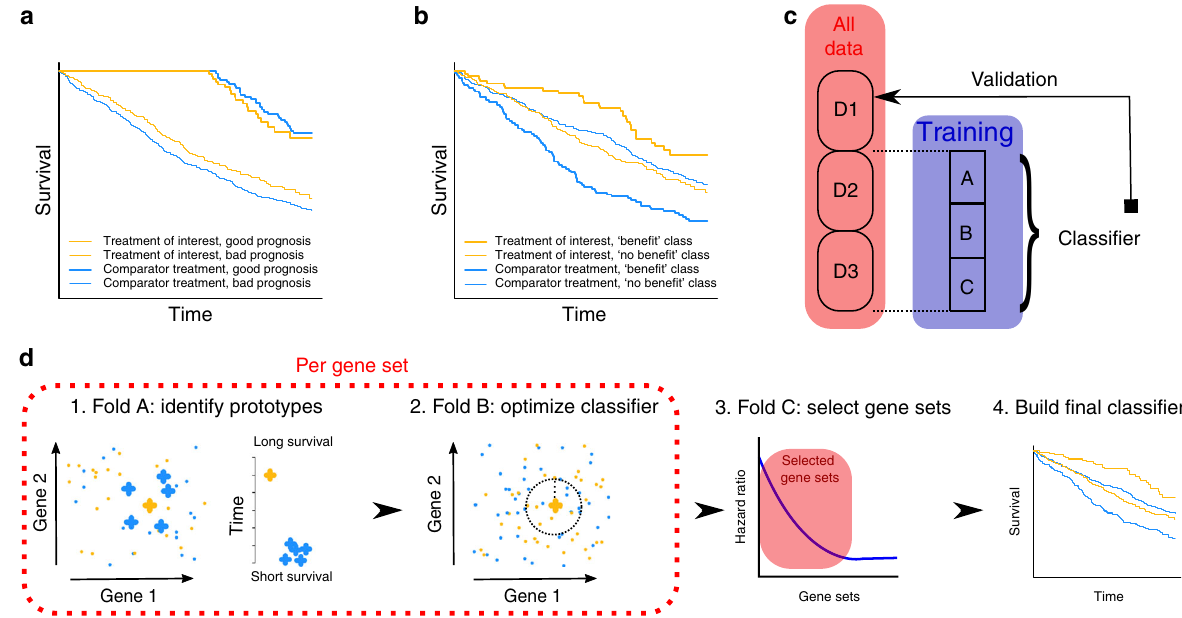
Fig. 1 Illustration of the difference between prognostic and predictive classi fi ers and an overview of the approach. a Example of the Kaplan – Meier curve for a prognostic classi fi er. b Example of the Kaplan – Meier curve for a predictive classi fi er. c Division of dataset into training and test sets. D1 – D3 are all used once to validate the classi fi er trained on the remaining two-thirds of data. d Flow of the GESTURE algorithm. In step 1 the prototypes with a longer than expected survival difference are identi fi ed on fold A. In step 2 the number of prototypes and corresponding decision boundary used in the classi fi er are optimized on fold B. In step 3 the performance of the classi fi er on fold C across all repeats is used to select the combination of gene sets to be used in the fi nal classi fi er. In step 4 a classi fi er for these gene sets is de fi ned on all training data. This classi fi er will be validated on the fold D not included in